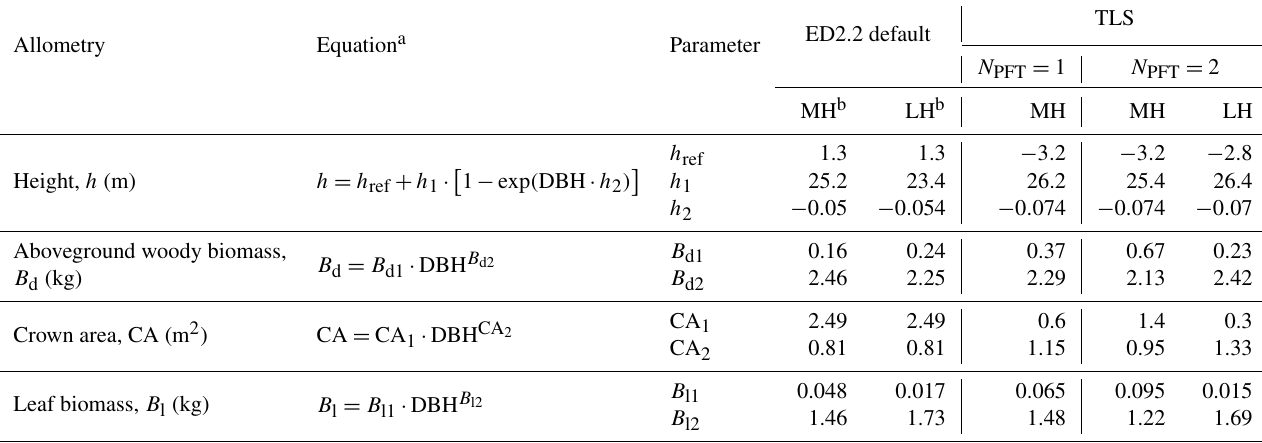
Table 3. List of allometries modified in this study, ED2.2 default and TLS-derived allometric coefficients (for one or multiple simulated PFTs). The corresponding curves are plotted in Fig.